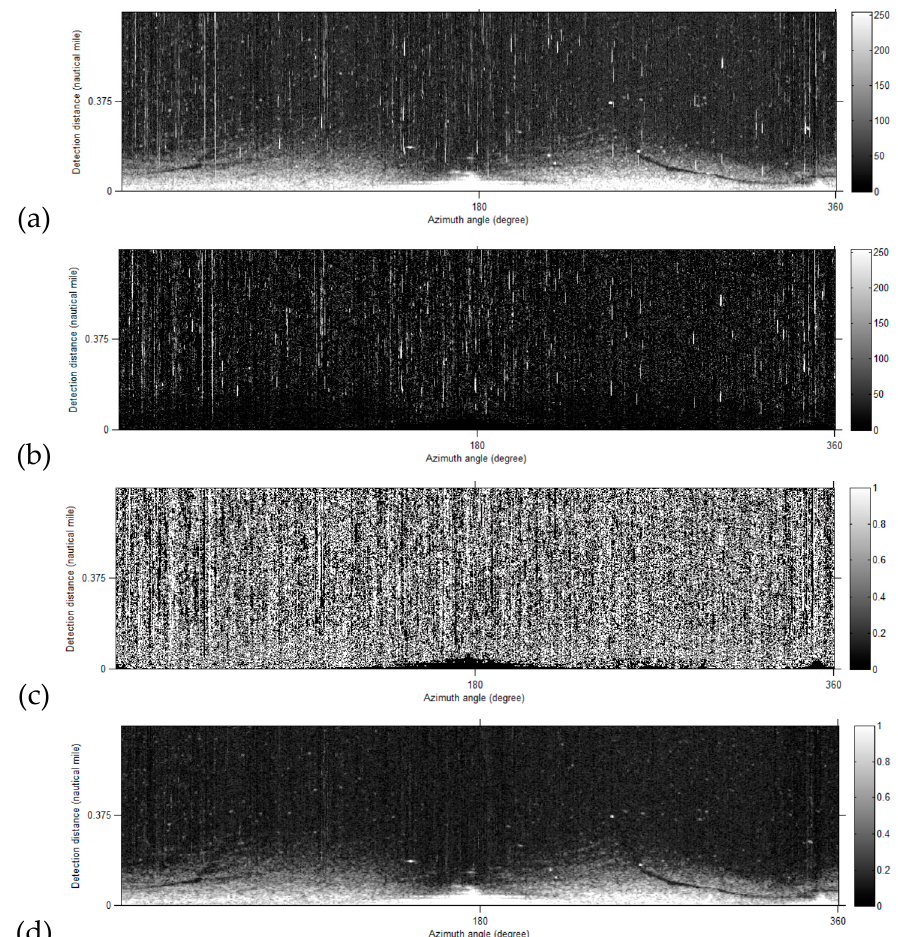
Remote Sens. 2019 , 11 , x FOR PEER REVIEW 9 of 21 Figure 7. Smoothing of Figure 3a. ( a ) The original image in a plane rectangular co-ordinate system; ( b ) convolution with a Laplace operator; ( c ) application of the Otsu method; ( d ) smoothing result.